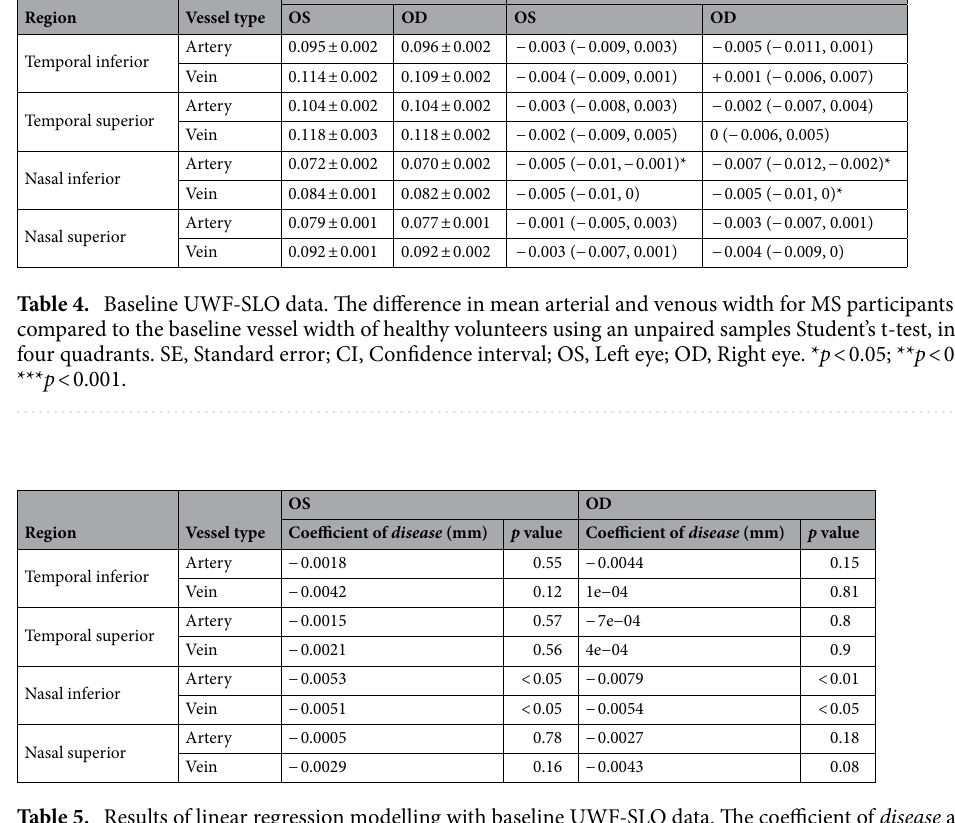
Table 5. Results of linear regression modelling with baseline UWF-SLO data. The coefficient of disease and its associated p value is shown for each retinal quadrant. OS, Left eye; OD, Right eye.